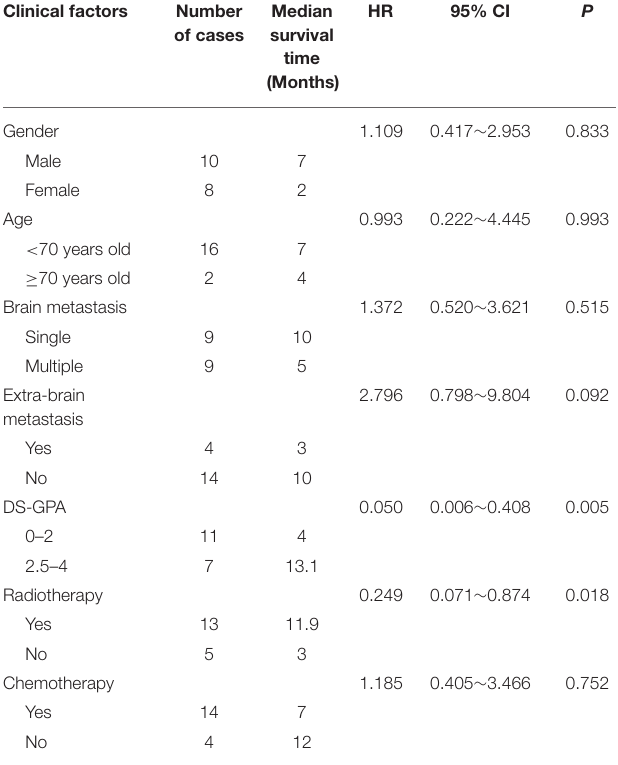
TABLE 3 | Univariable cox proportional regression analysis of factors associated with overall survival (OS). Clinical factors